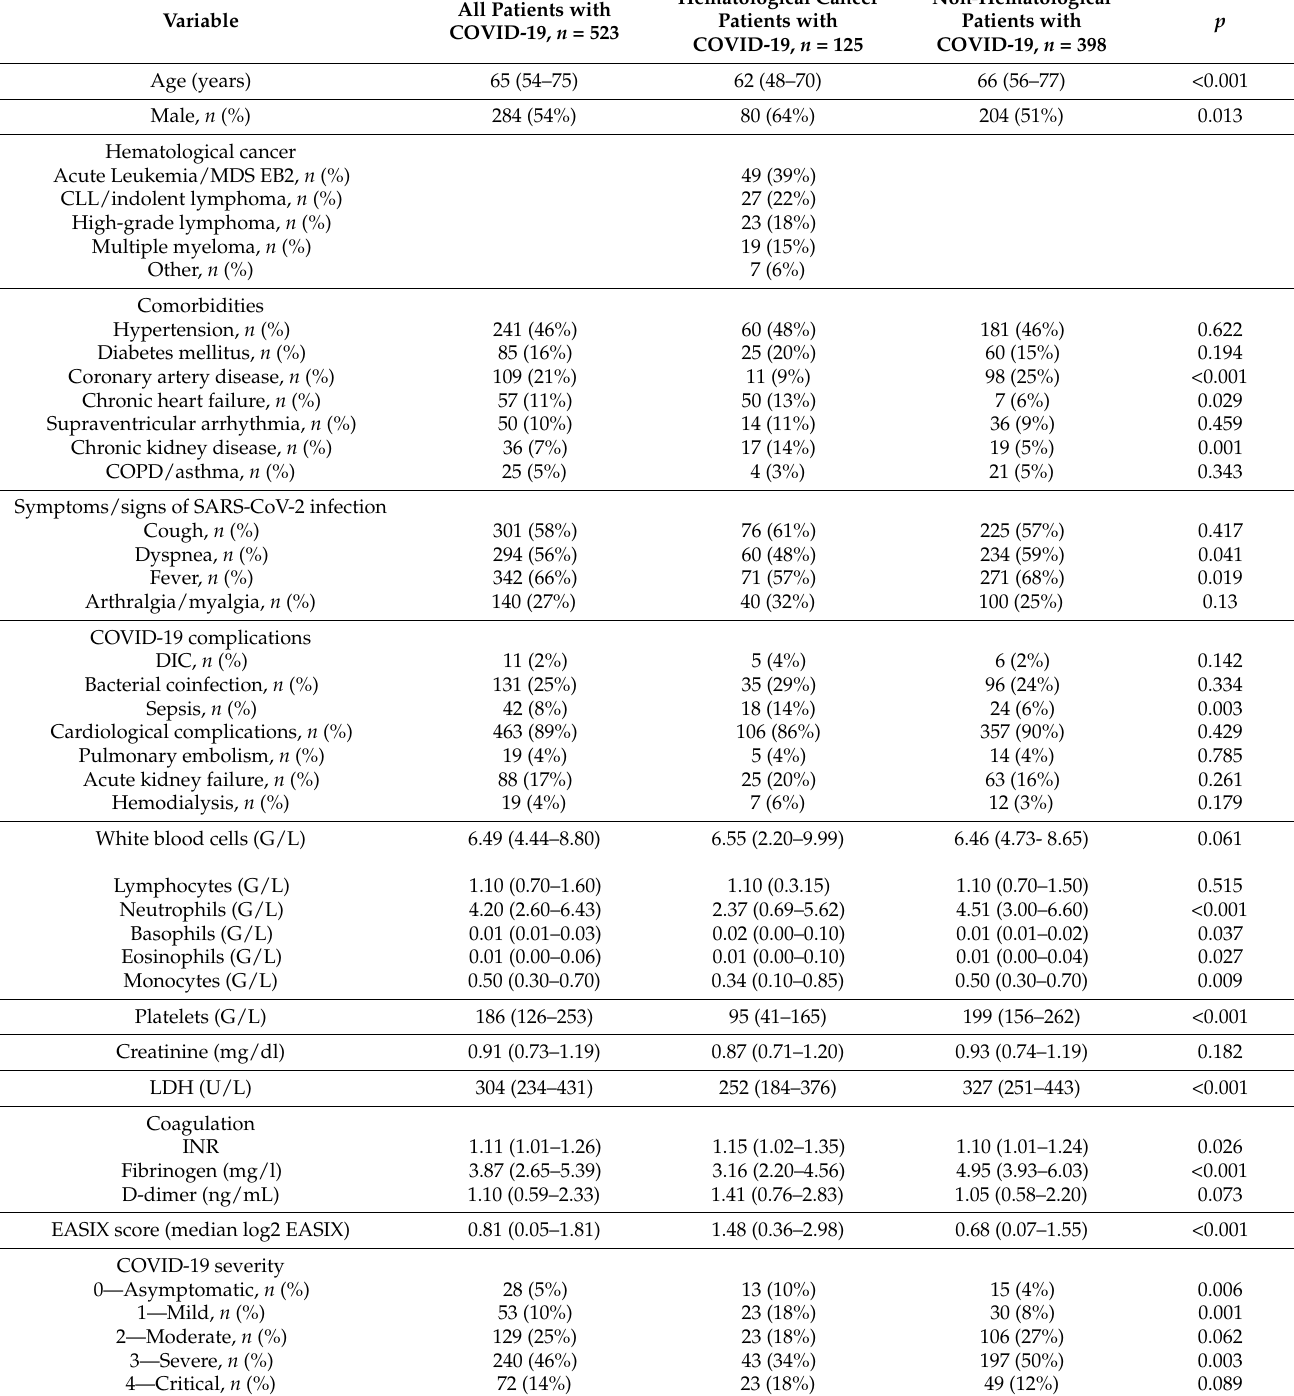
Table 1. Clinical characteristics of patients with COVID-19 (hematological versus non-hematological). Variable